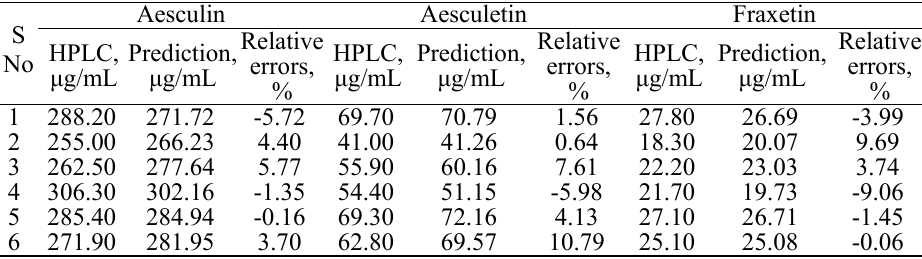
Table 5 . The results of the models for the analysis of unknowns Aesculin Aesculetin Fraxetin S Relative HPLC, Prediction, No errors, μ g/mL μ g/mL